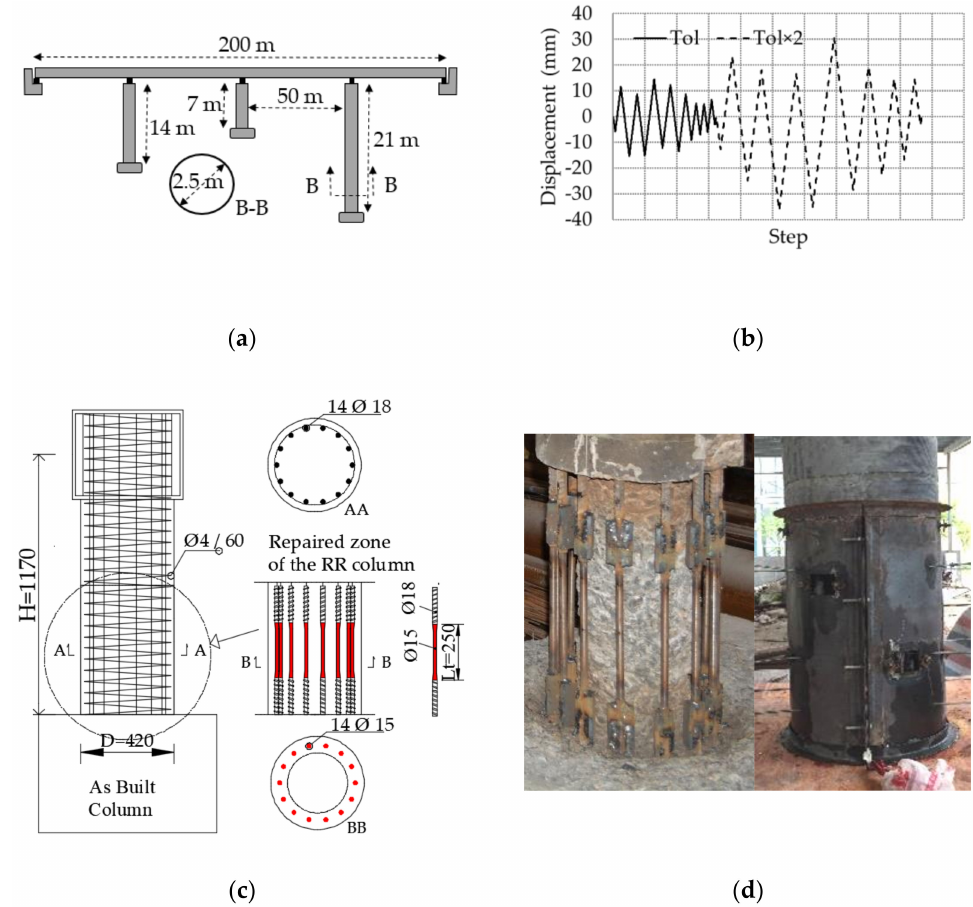
Figure 7. ( a ) Bridge geometries, ( b ) applied displacement history to test the scaled pier, ( c ) geometries and reinforcement of the 1:6 scale pier (mm), and ( d ) proposed repair strategy: Rebar substitution and concrete jacket building.